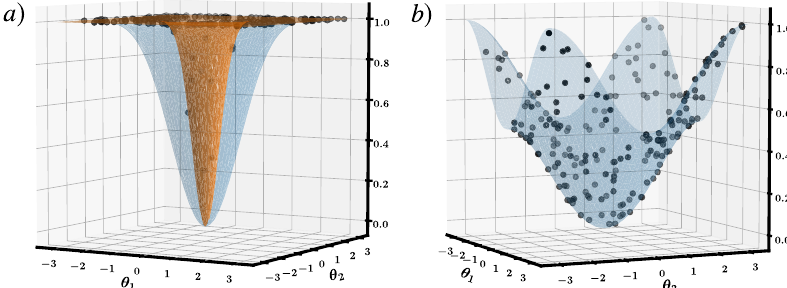
Q n 2 ð θ j = 2 Þ for n = 4 (blue) and n = 24 j ¼ 1 cos cos 2 ð θ j = 2 Þ is independent of n . In both cases, 200 Haar distributed points are ¼ 1